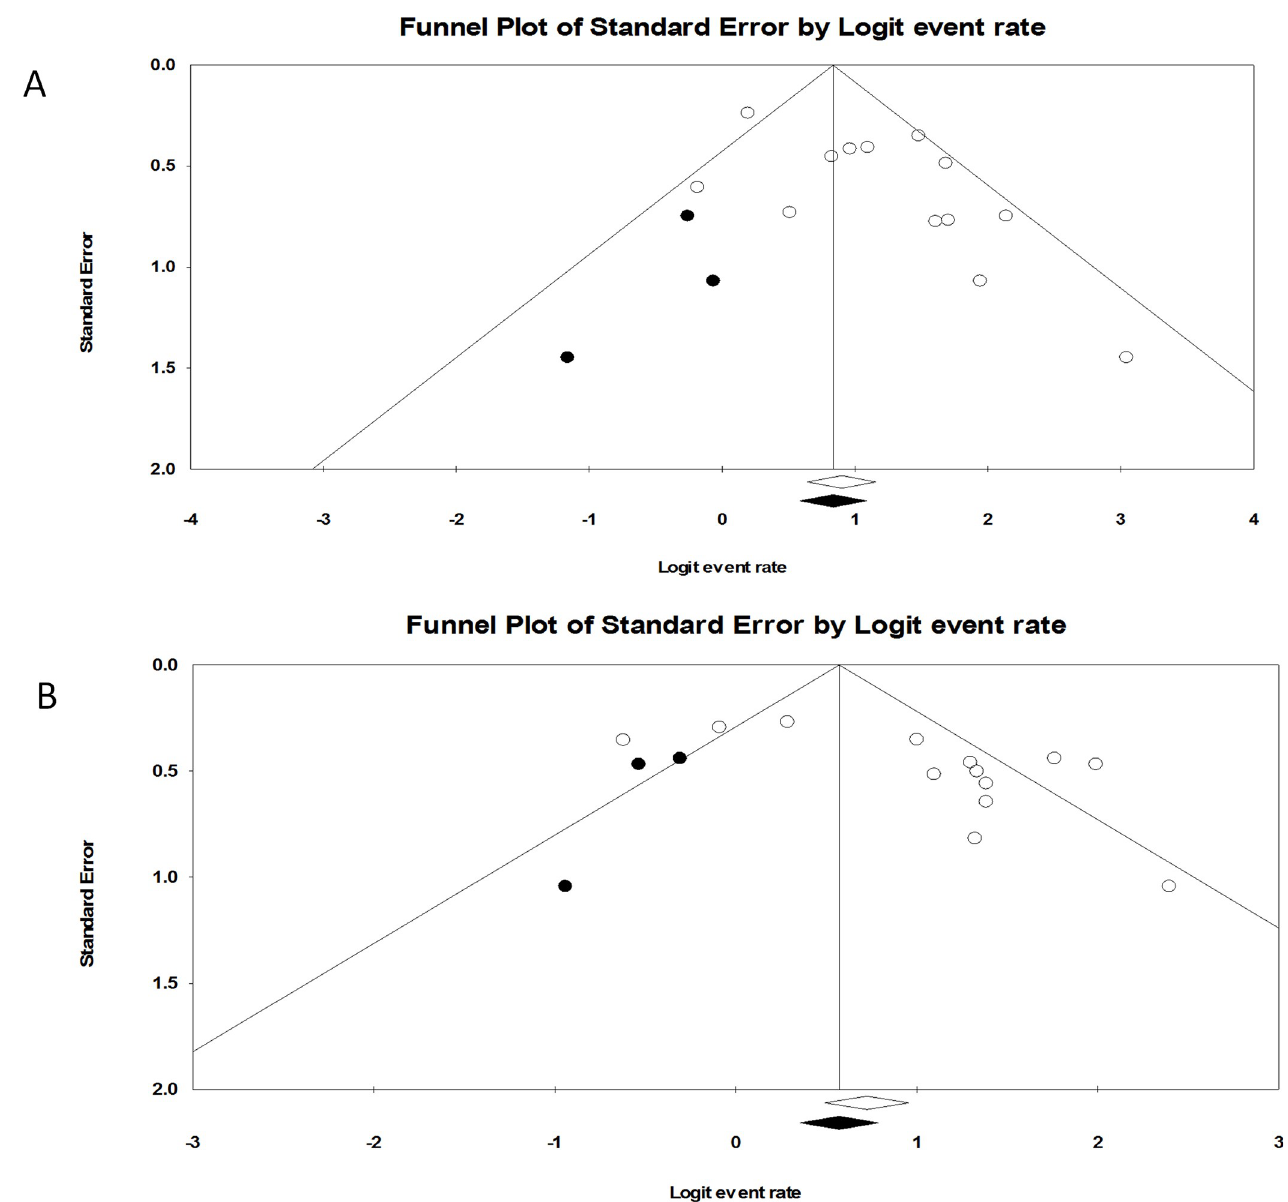
Fig 9. Adjusted funnel plot after trim and fill indicated the exit of publication